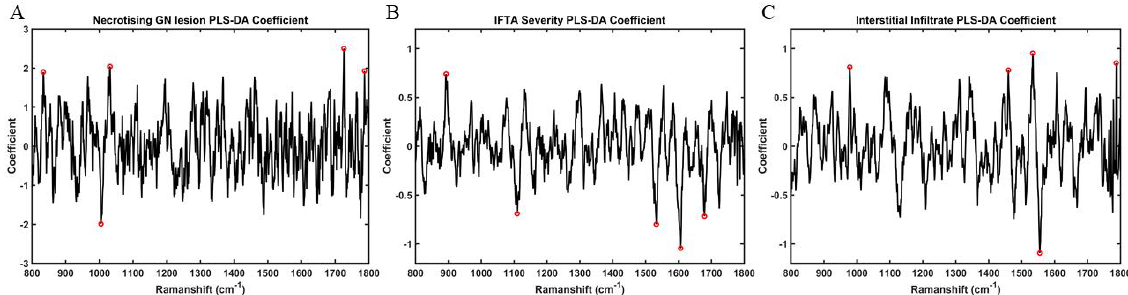
Figure 5. PLS-DA coefficients for identification of spectral biomarkers from tissue samples (n = 27) —( A ) Wavenumber variables associated with necrotising glomerular (GN) lesions: 1726 cm − 1 (C=O stretching vibrations of cortisone), 1031 cm − 1 (C-H in-plane bending mode of phenylalanine), 833 cm − 1 (asymmetric O-P-O stretching of tyrosine), 1787 cm − 1 (C=O stretching vibrations of cor- tisone) ( B ) Wavenumber variables associated with interstitial fibrosis & tubular atrophy (IFTA): 893 cm − 1 (phosphodiester deoxyribose) ( C ) Wavenumber variables associated with interstitial infil- trate: 1533 cm − 1 (amide carbonyl group vibrations and aromatic hydrogens), 1787 cm − 1 (C=O stretch- ing vibrations of cortisone), 978 cm − 1 (C-C stretching in β -sheet proteins), 1459 cm − 1